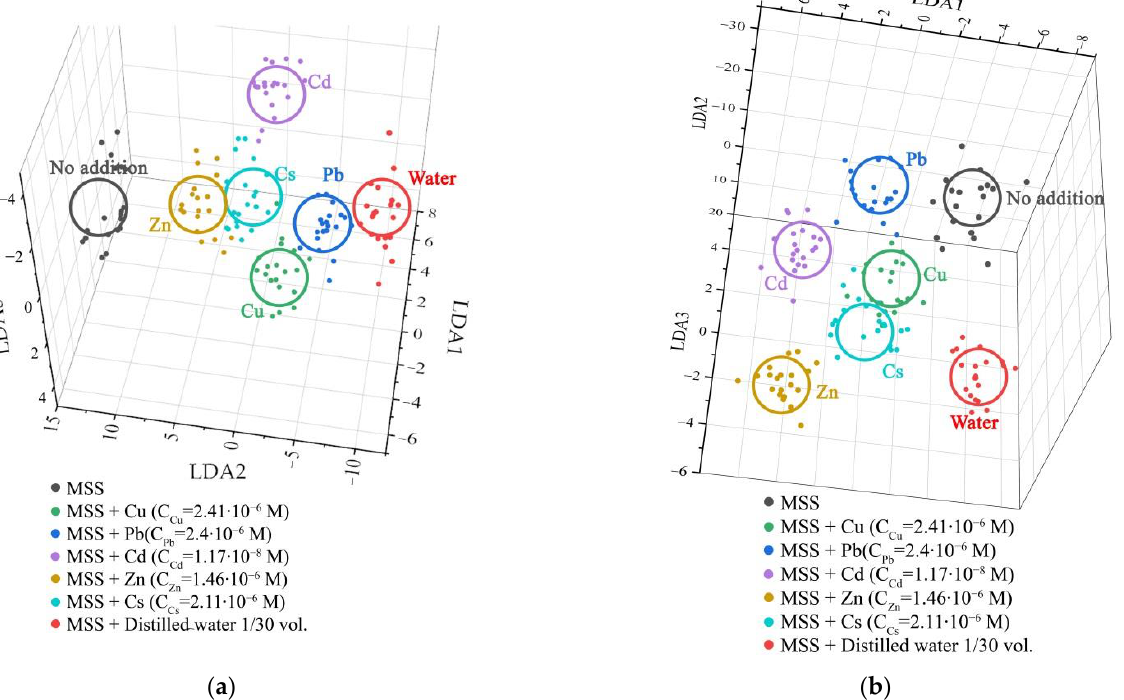
Figure 7. The 3D projection of the first three LDA components of 6D LDA coordinate system built to recognize vector signals of the fluorescent probe array versus seven test analytes added to 3 mL of solution containing the fluorescent probe array: ( a ) 0.1 mL volume of each test analyte; ( b ) 0.5 mL volume of each test analyte. The salt concentrations are drawn in the